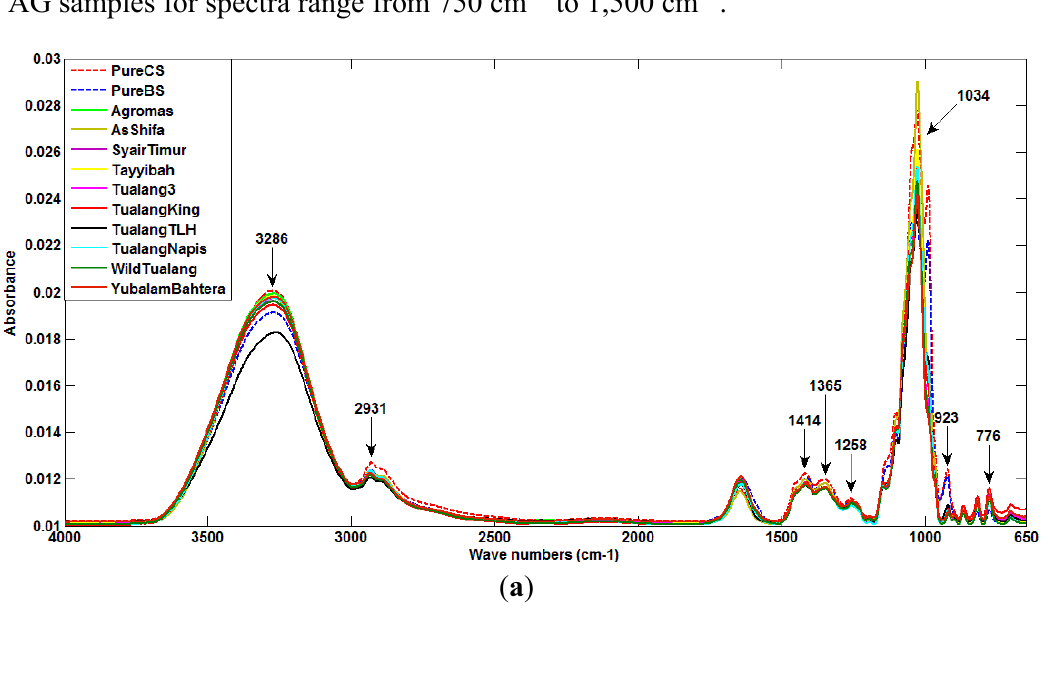
Figure 2. ( a ) All Pure Tualang honey and sugar solutions for full spectra range (650 cm −1 to 4,000 cm −1 ). ( b ) All AG honey sample for full spectra range (650 cm −1 to 4,000 cm −1 ). ( c ) AG samples for spectra range from 750 cm −1 to 1,500 cm −1